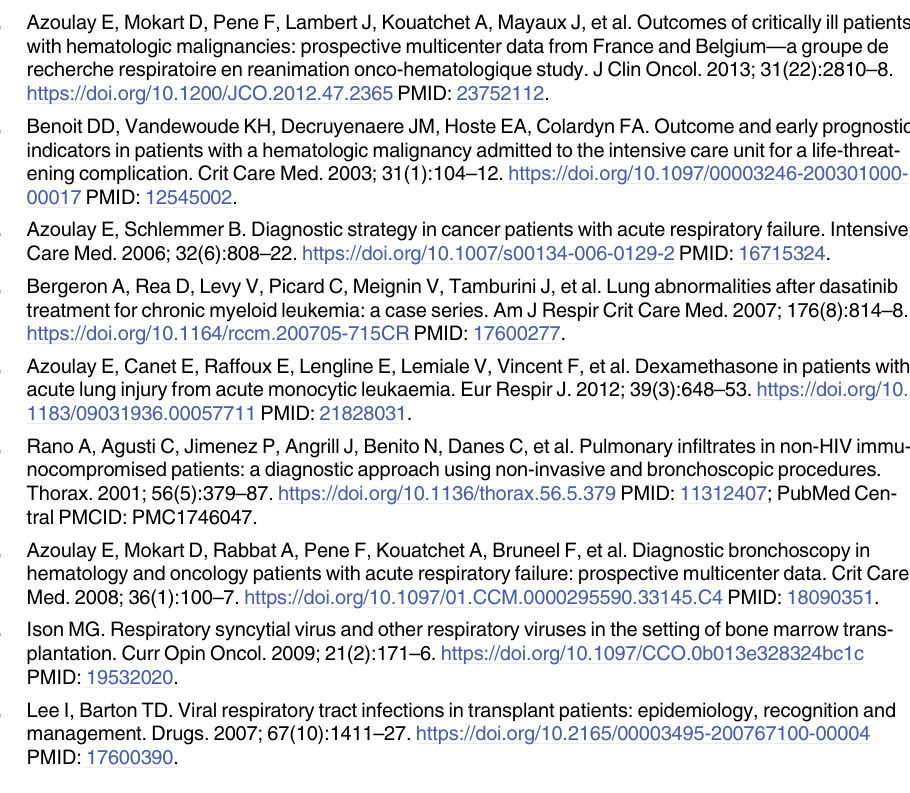
S7 Table. Comparison of the clinical characteristics of hospital survivors and non-survi- vors in patients with positive upper airway respiratory virus PCR. S8 Table. Multivariate analyses with logistic regression models for probability of in-hospi- tal mortality in patients with positive upper airway respiratory virus